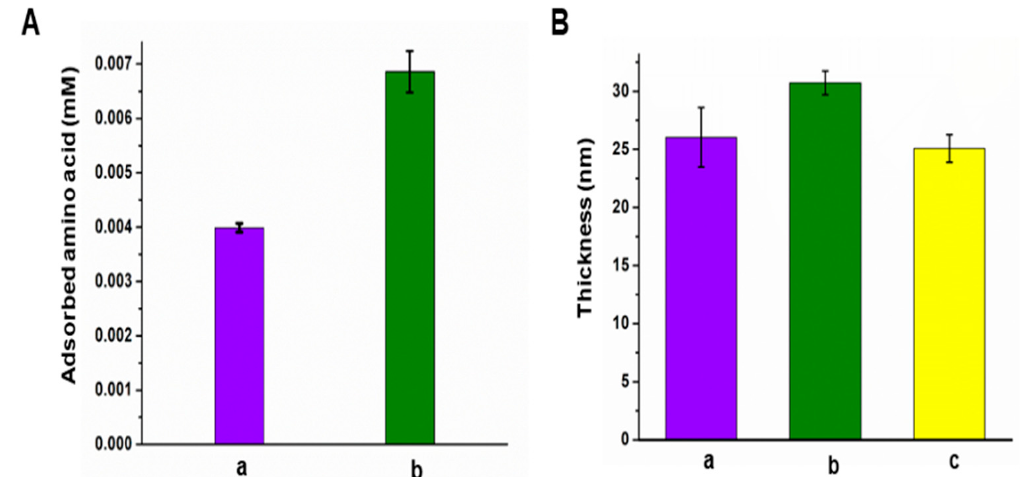
Figure 5. ( A ) Quantification of adsorbed amino acids using a Bradford assay and ( B ) Thickness of plasma coating evaluated using ellipsometry for a—OB-POX/L-Trp , b—OB-POX/D-Trp, c—OB-POX.